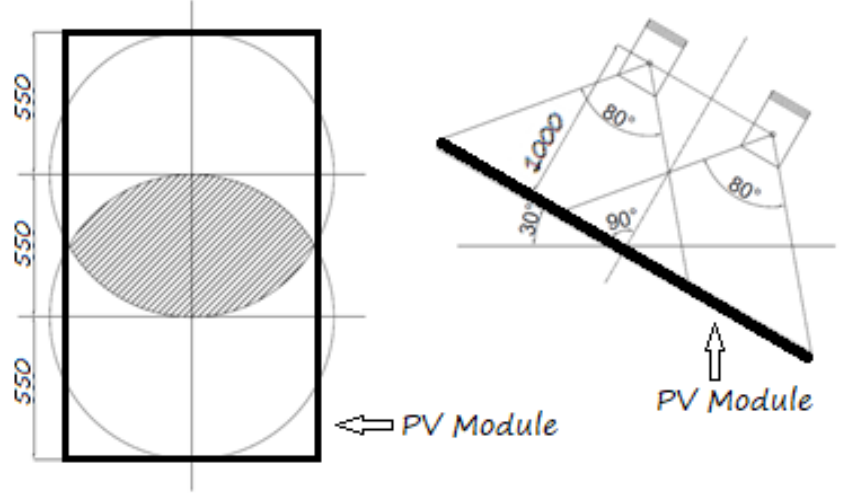
Figure 4. Lamp illuminated area on the panel module surface ( left ) and lamp inclination with respect to module surface ( right ). Dimensions are expressed in